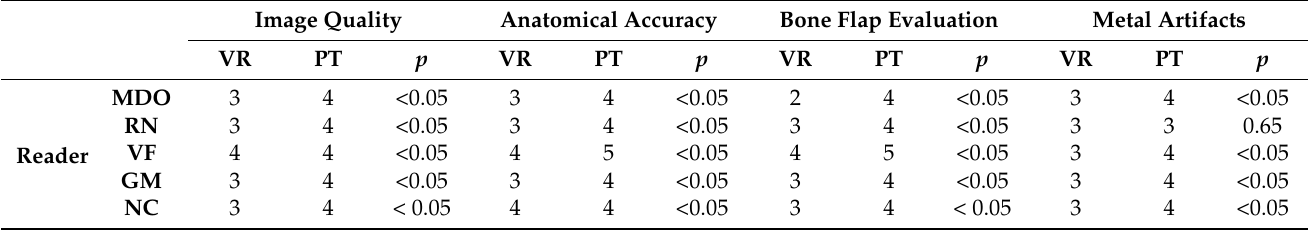
Table 3. Likert’s scale evaluation results across all readers and parameters. Values are expressed as